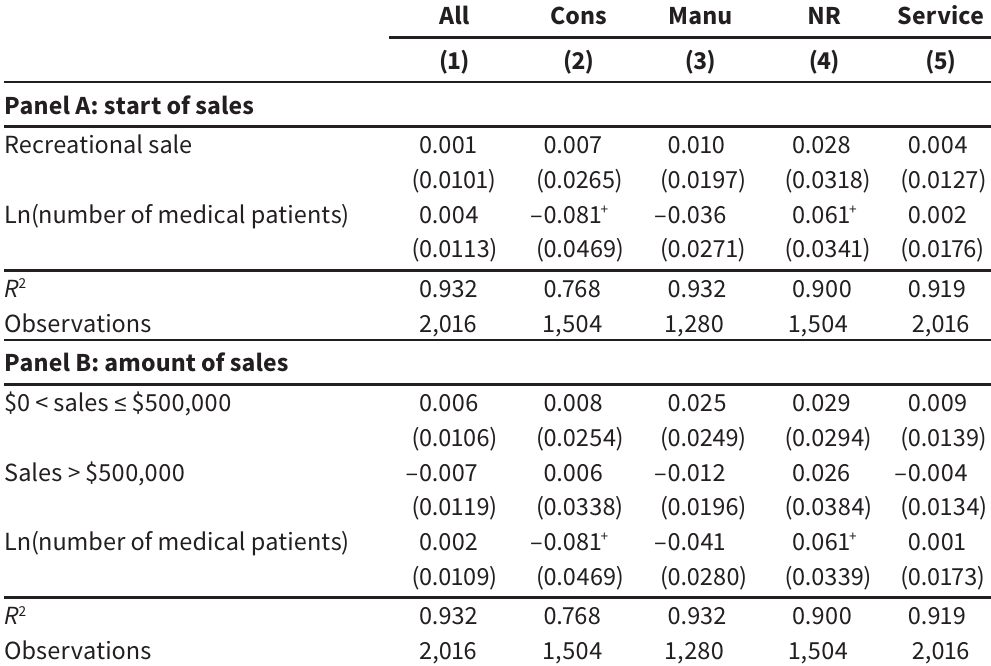
The effect of recreational dispensary entry on wages – regression